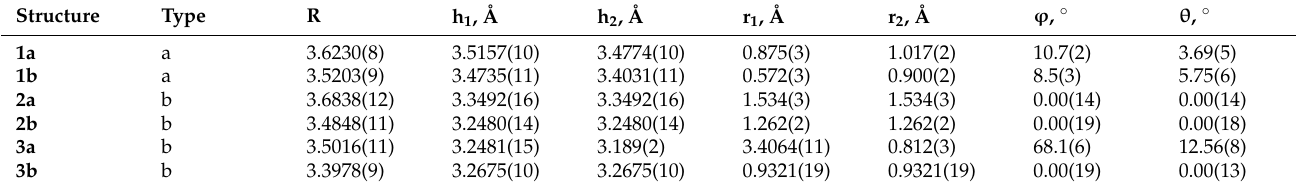
R—distances between the centroid of one ring to the centroid of another ring. h i —distances between the centroid of one ring to the plane of another. r i —distances between the centroid of one ring and projection of another ring centroid to the first plane (shift). ϕ —twist angle. θ —the angle between ring